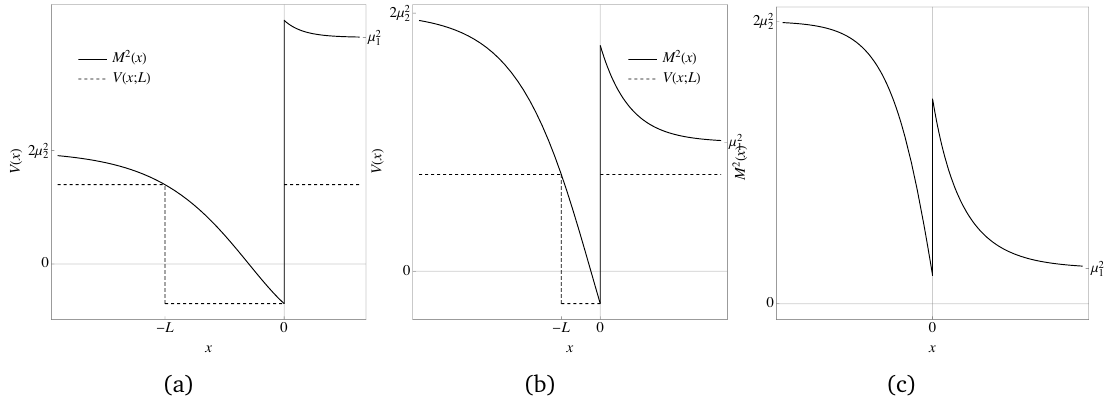
Figure 8: The potential M 2 ( x ) (solid line) and their corresponding lower bound- ing square-well potentials V ( x ; L ) (dotted line) when: (a) µ 2 µ 2 / 2 < µ 2 < 2 µ 2 > 2 µ 2 , and (c) µ 2 . In (c), since M 2 ( x ) is already positive, we 1 2 1 2 1 do not need a lower bounding square-well